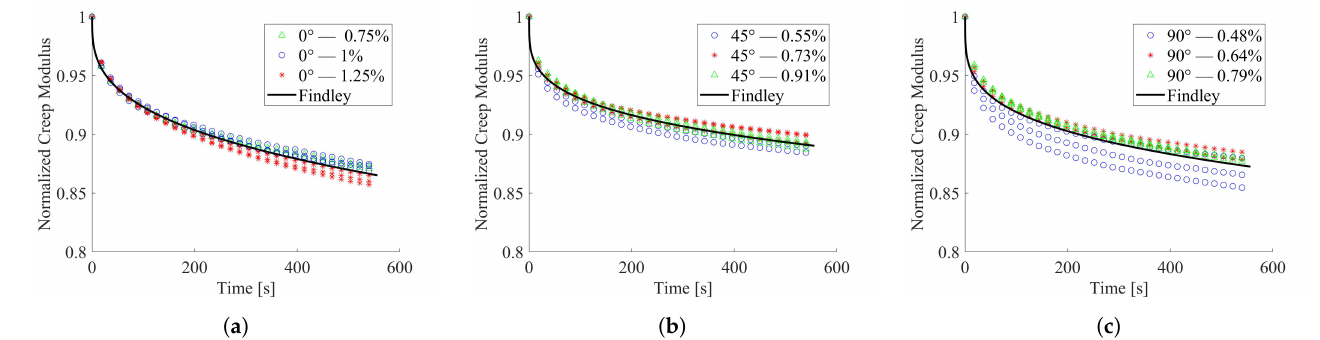
Figure 7. Trend of normalized creep modulus at room temperature; ( a ) 0° infill orientation; ( b ) 45° infill orientation; ( c ) 90° infill orientation.